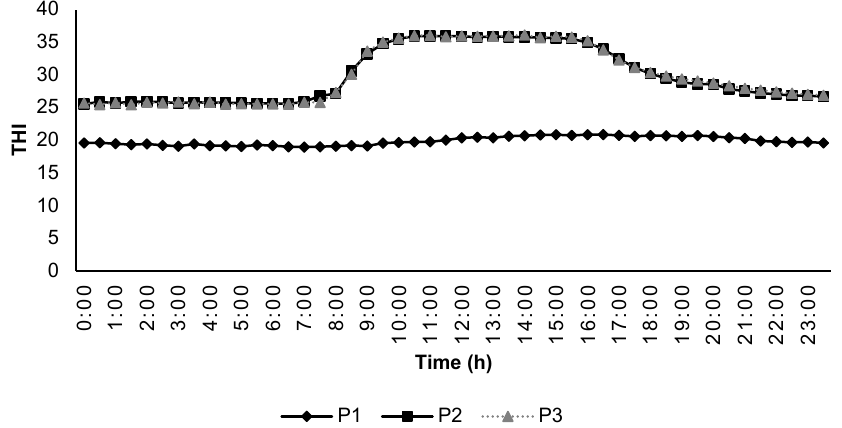
Figure 1. Temperature humidity index inside the climatic chambers during the experimental peri- ods.